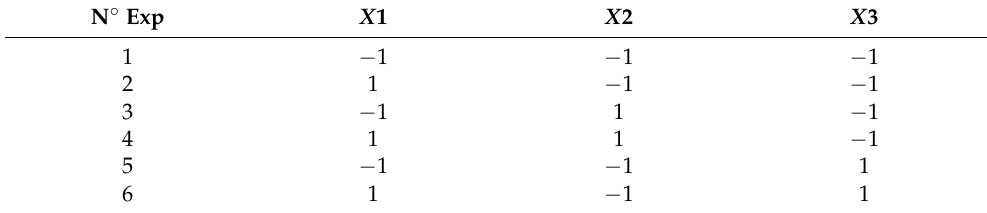
Table 5. Experimental